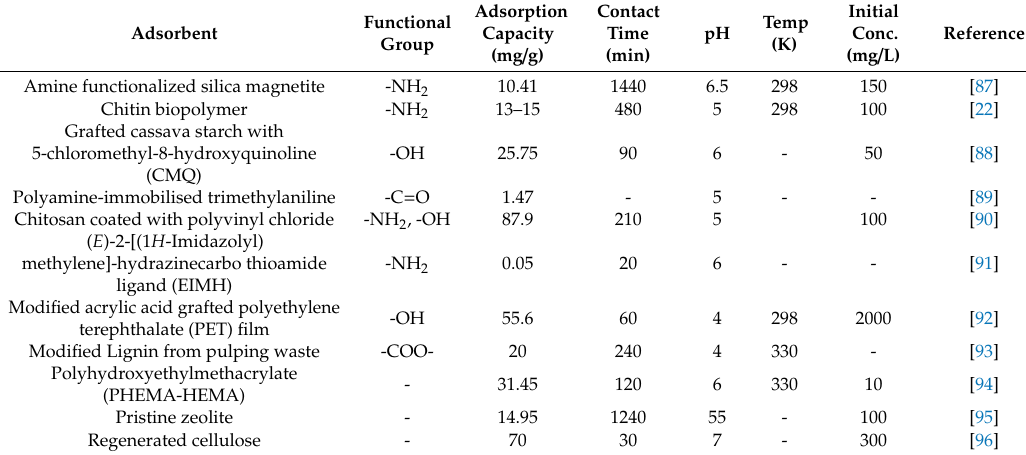
Table 5. Summarised maximum adsorption conditions and their functional group for various natural and synthetically modified polymer.